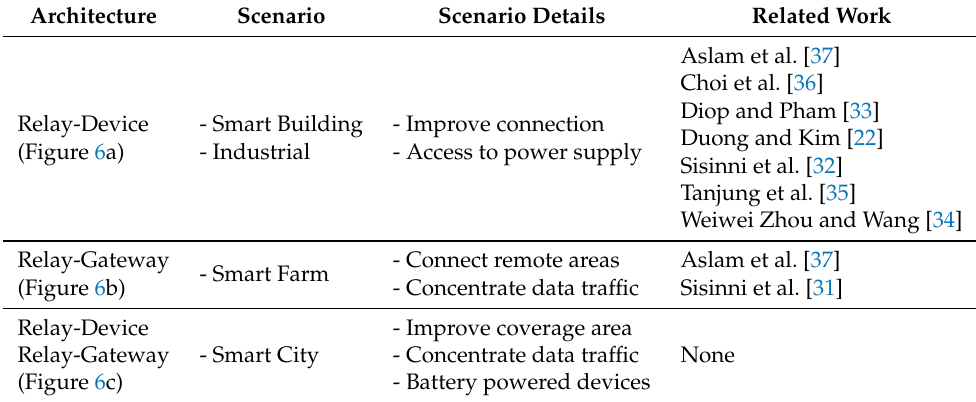
Table 5. Topology